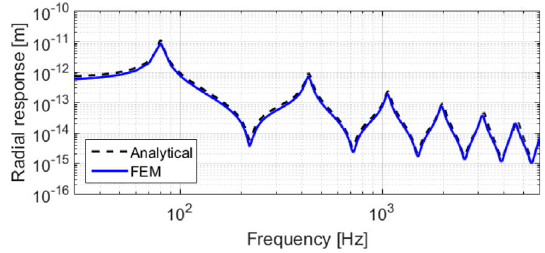
Figure 23. Comparison of numerically and analytically calcu- lated de fl ections at one end for thickness asymmetrical tube.